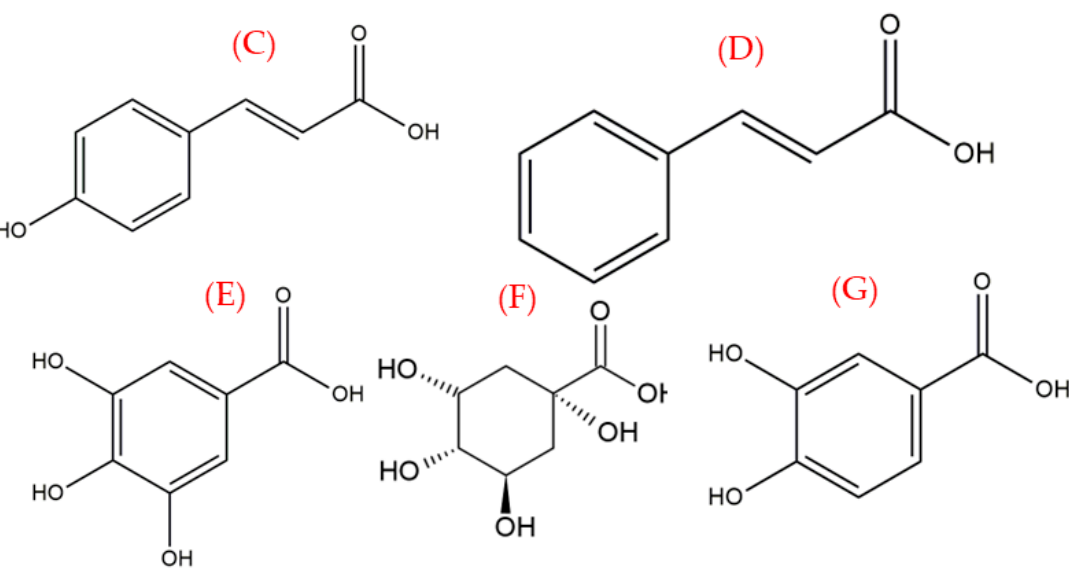
Figure 3. Structures of chlorogenic acid ( A ), caffeic acid ( B ), p -coumaric acid ( C ), cinnamic acid ( D ), gallic acid ( E ), quinic acid ( F ), and protocatechuic acid ( G ). Table 1. Phytochemical constituents of lemongrass.